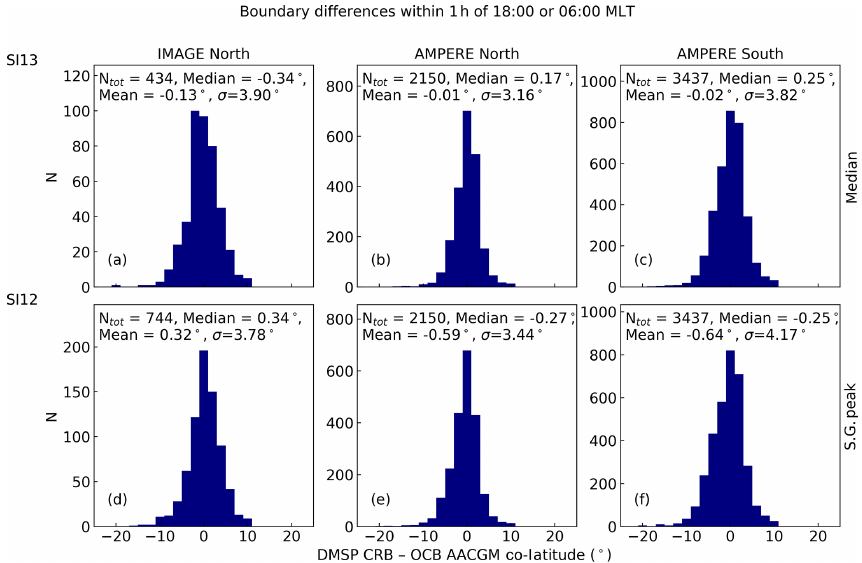
Figure 5. Histograms showing the differences between DMSP CRB and IMAGE or AMPERE OCB using paired boundaries that occur within 1h of 06:00 or